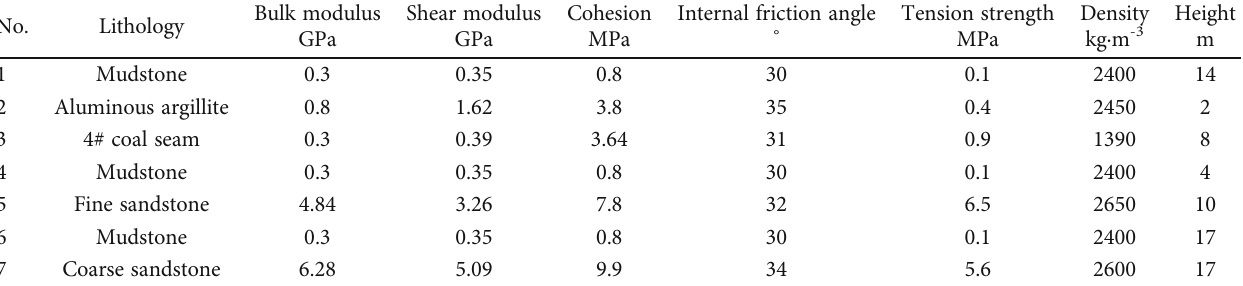
Table 2: Rock mechanics